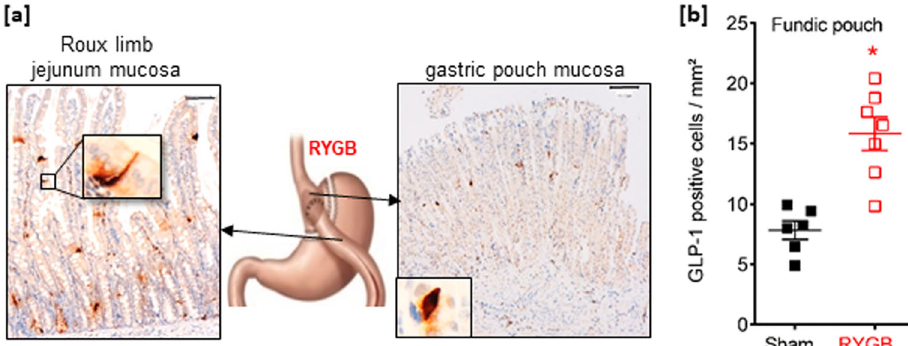
Fig. 4 The density of fundic GLP-1-positive cells increases after RYGB surgery in rats. a Representative photomicrograph showing few GLP-1-positive cells in the gastric pouch fundic mucosa and the alimentary Roux limb (RL) jejunum mucosa section from one RYGB-operated rat. Bar scale 100 µ m. Insert: high magni fi cation of a GLP-1-positive cell. The included image is the property of Johnson and Johnson and Ethicon Endo-Surgery (Europe) and is reproduced here with their kind permission. b Quanti fi cation of the number of GLP-1 immunoreactive cells per mm 2 in the fundic pouch. Data are presented as scatter data plots with mean ± SEM and were analyzed using Mann – Whitney test. * P < 0.05. Source data are provided as a Source data fi le.